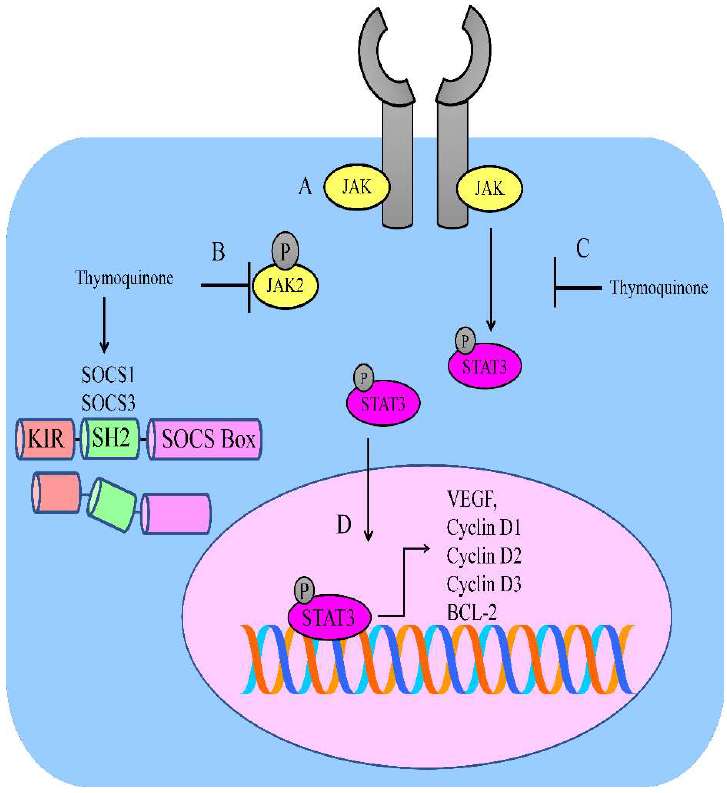
Figure 1. (A) JAK/STAT-mediated signaling is regulated by thymoquinone. (B–C) Thymoquinone inhibited JAK2 and STAT3. Thymoquinone stimulated the expression of SOCS1 and SOCS3. (D) STAT3-mediated upregulation of VEGF; BCL-2; and cyclin D1, D2, and D3.